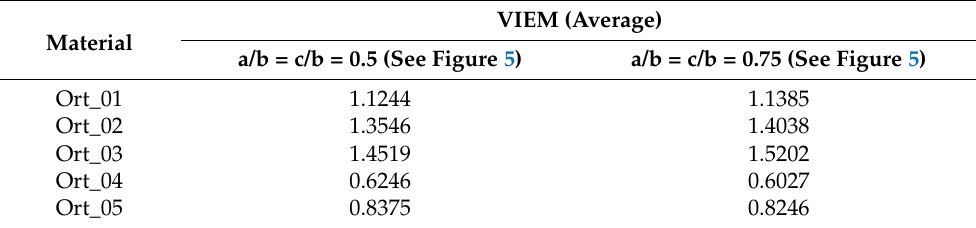
Table 13. Normalized Tensile Stress Component ( σ xx / σ o xx ) within the Orthotropic Prolate Spheroidal Inclusion due to Uniform Remote Tensile Loading ( σ o xx